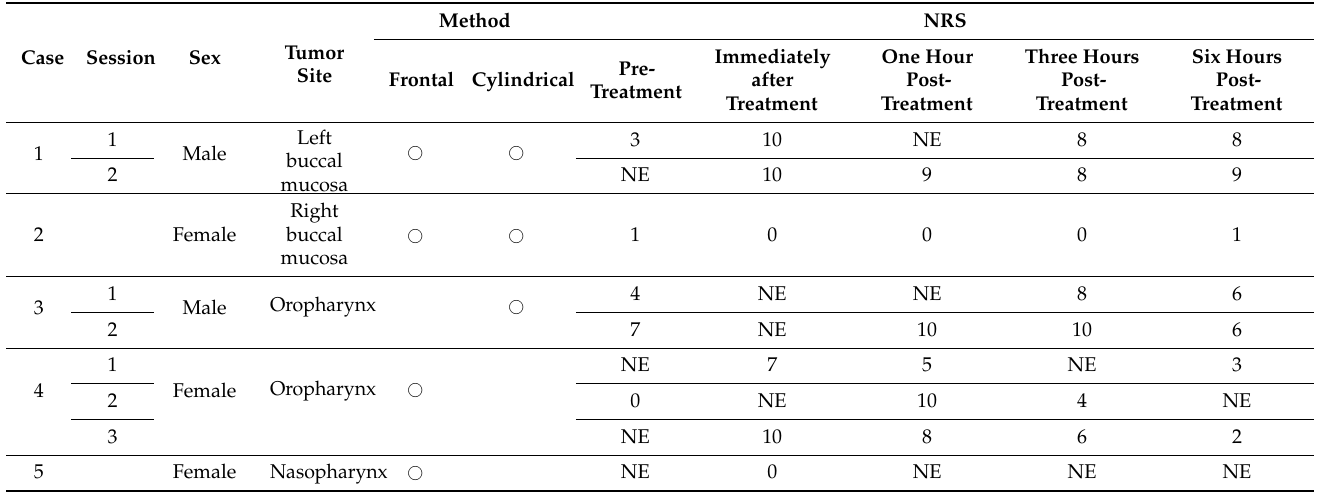
Table 2. NRS changes immediately after PIT.